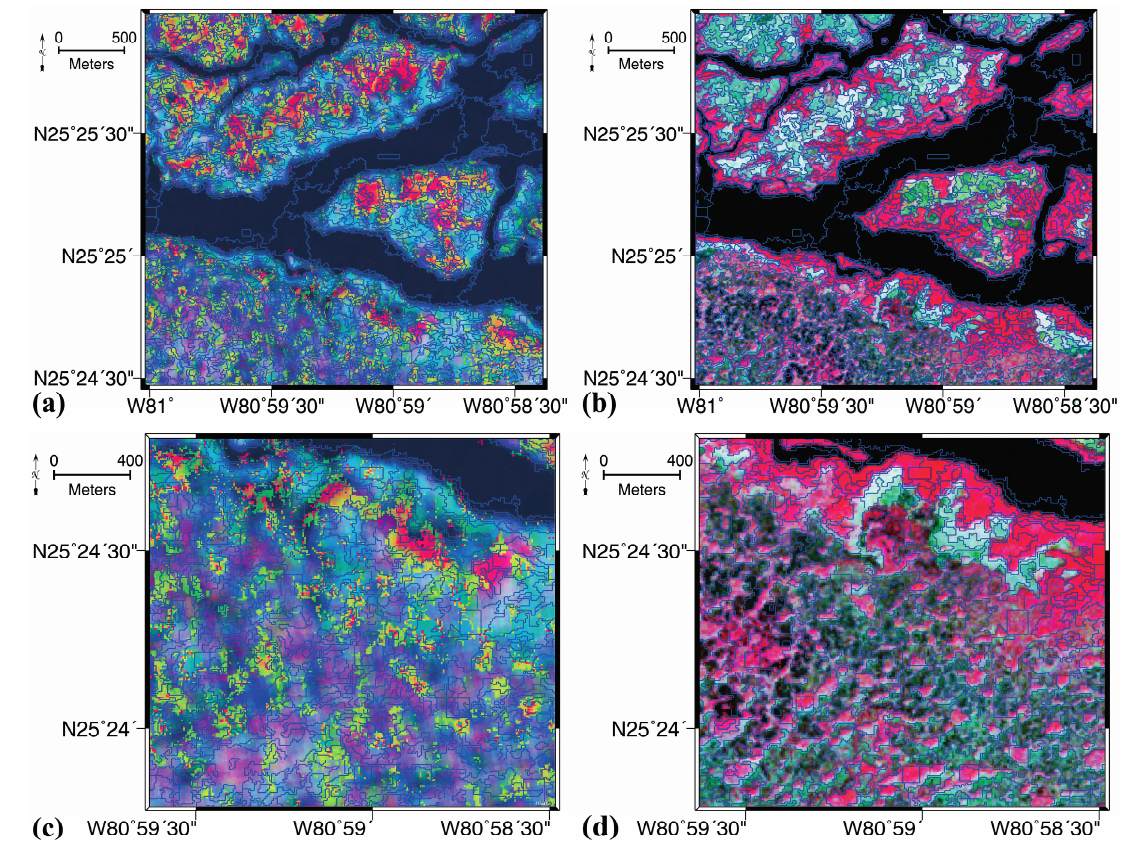
Figure 7. Segmentation results of type O displayed on the TSX image using false-color composite image decomposition layers (red = double bounce scattering, green = volume scattering, and blue = single bounce scattering in [a] and [c]) and on the RapidEye image using false-color composite images (red = near infrared, green = red visible, and blue = green visible bands in [b] and [d]); ( a , b ) are near tidal canals; ( c , d ) are near inland